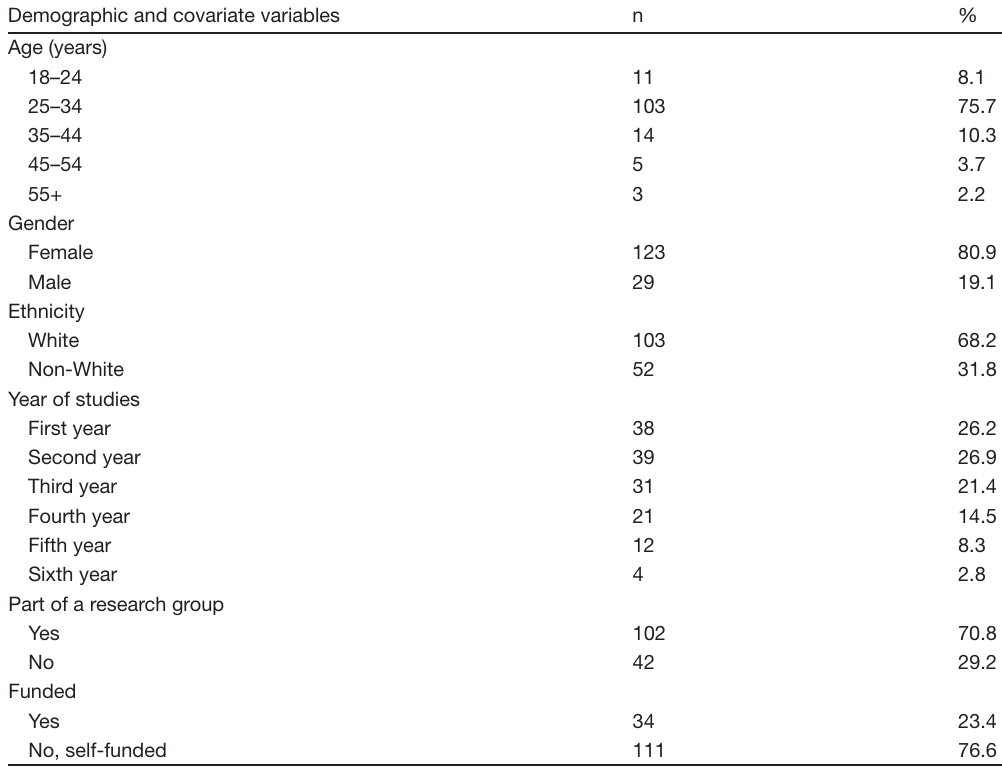
Table 1. Demographic and educational variables by n of cases and